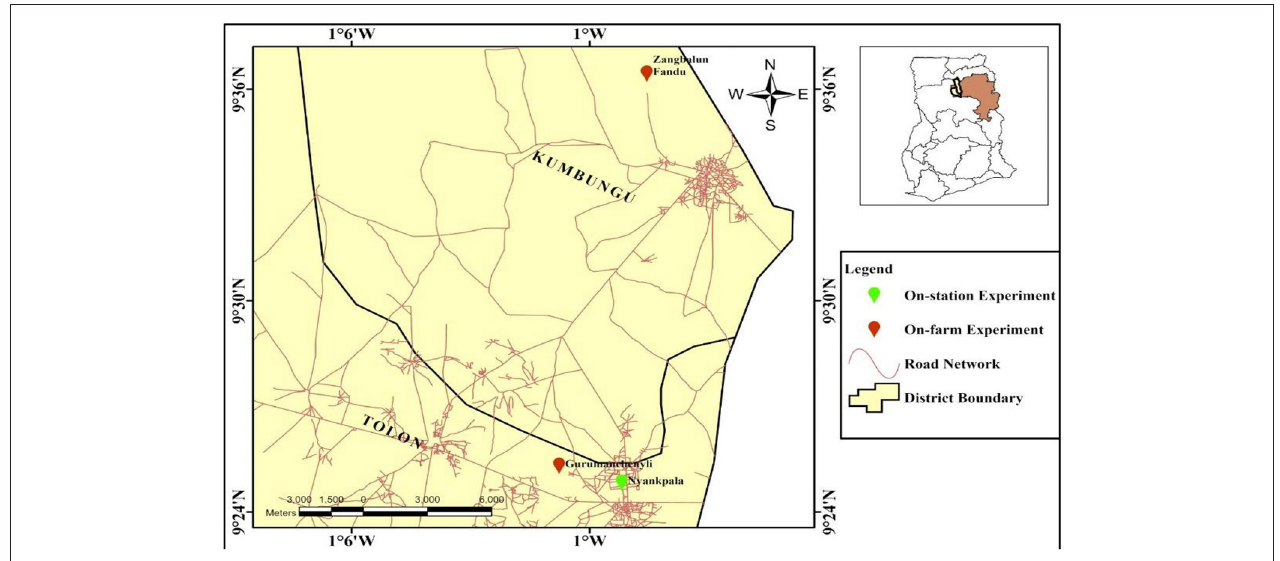
FIGURE 1 | Map of Ghana showing location of the experimental